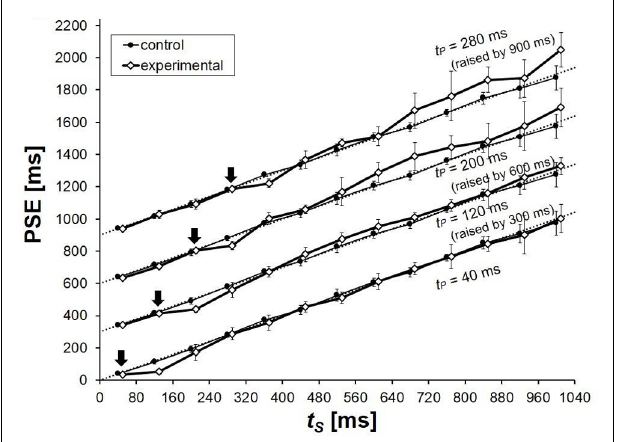
FIGURE 4 | Mean PSEs obtained from six participants in Experiment 3. PSE corresponds to the duration of t C that was perceived to be equal to the duration of t S .The results for t P = 120, 200, and 280 ms were raised by 300, 600, and 900 ms, respectively, in this graph for clarity.The physical values of t S (the points of objective equality) are indicated by dotted lines, on which t P values are indicated by arrows. Error bars represent standard deviations between